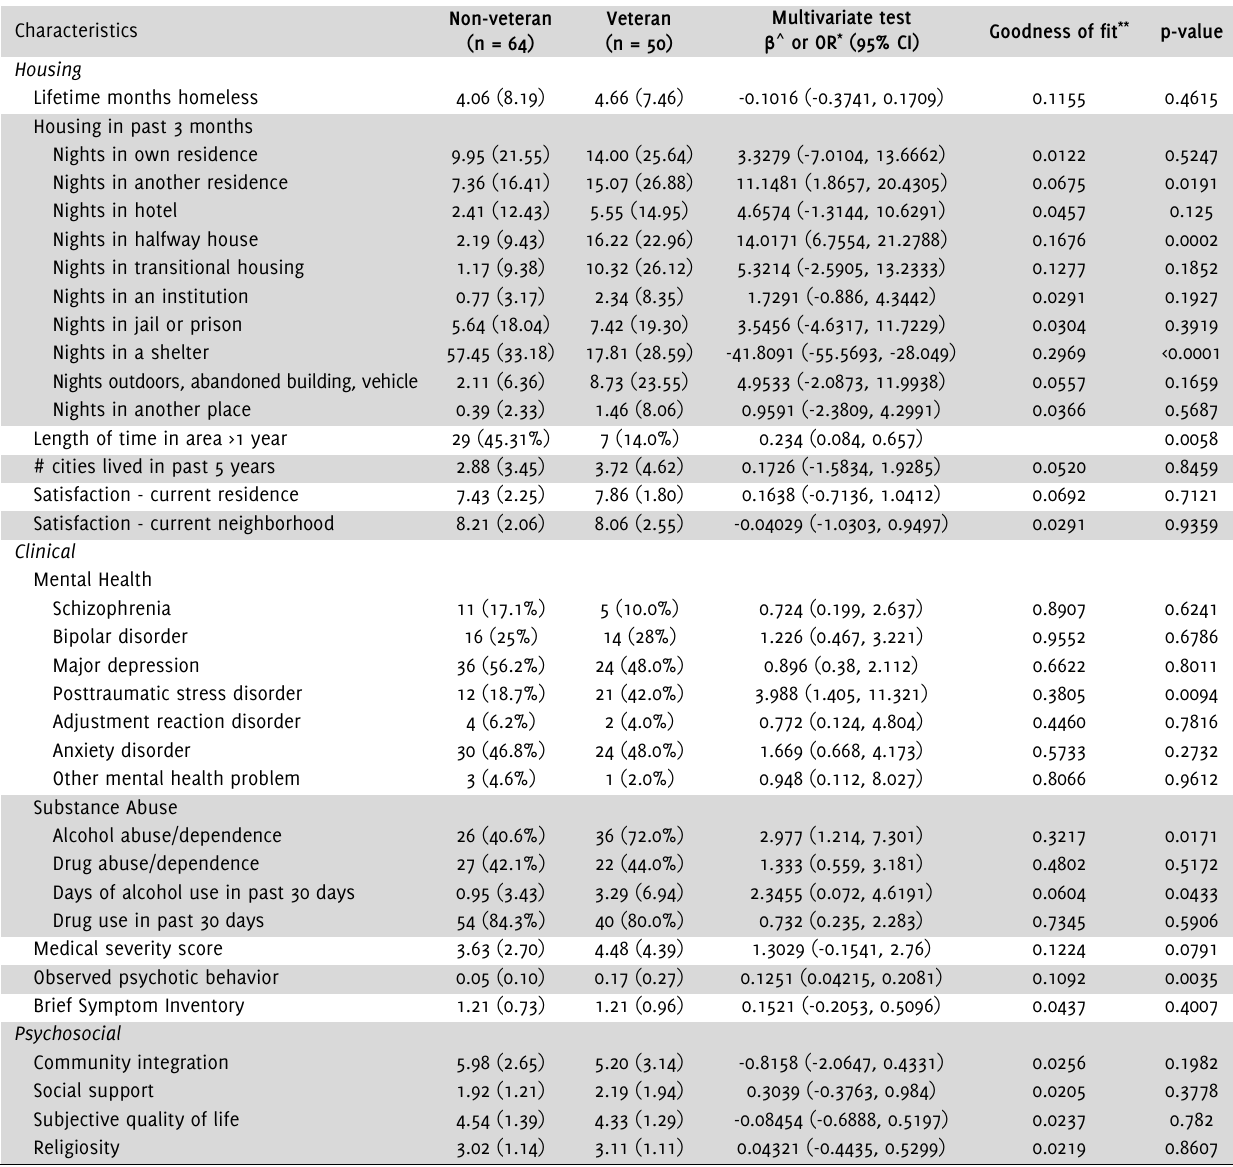
Table 2 . Housing, Clinical, and Psychosocial Factors of Rural Homeless Veterans and Non-Veterans.